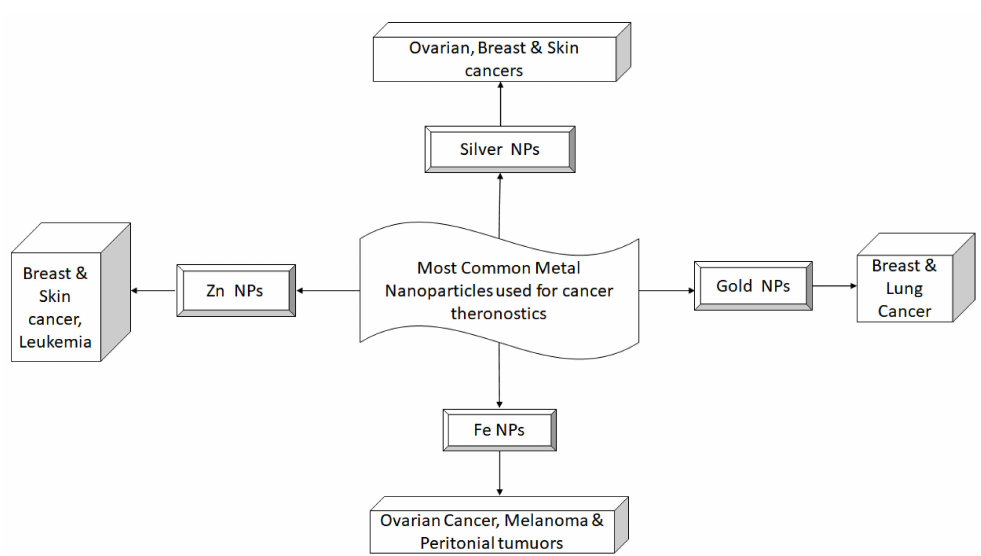
Figure 4. Summary of metallic nanoparticles used in various cancer